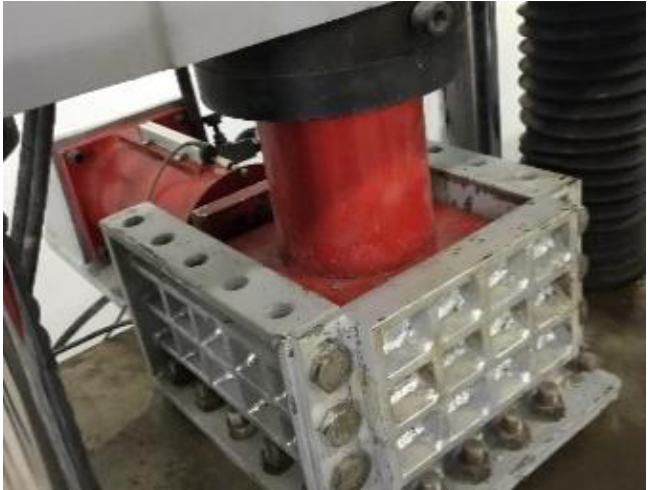
Figure 6. Schematic diagram of axial loading on the samples.